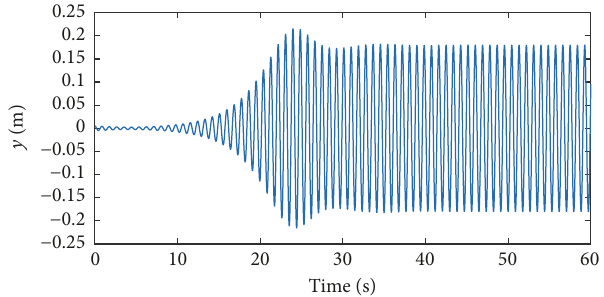
Figure 3: Simulation response for the secondary system when there is autoparametric interaction.